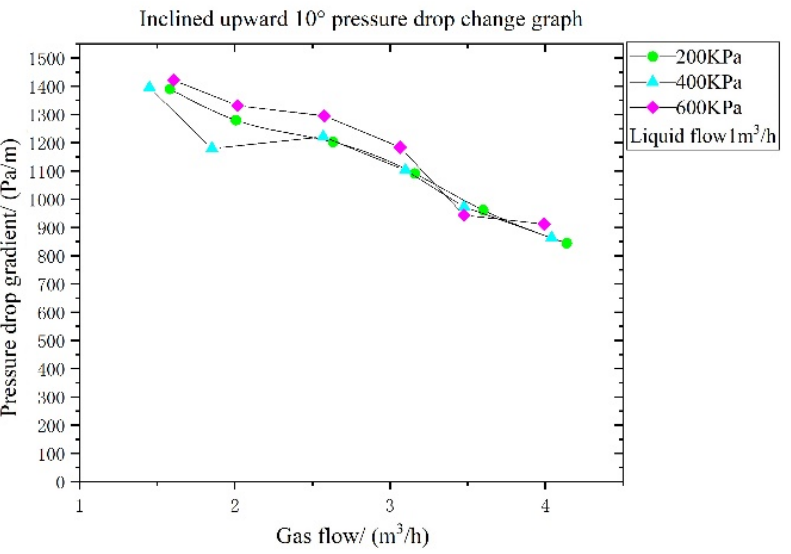
Figure 15. Pressure gradient diagram at different pressures and gas flow rates at 10° upward tilt.